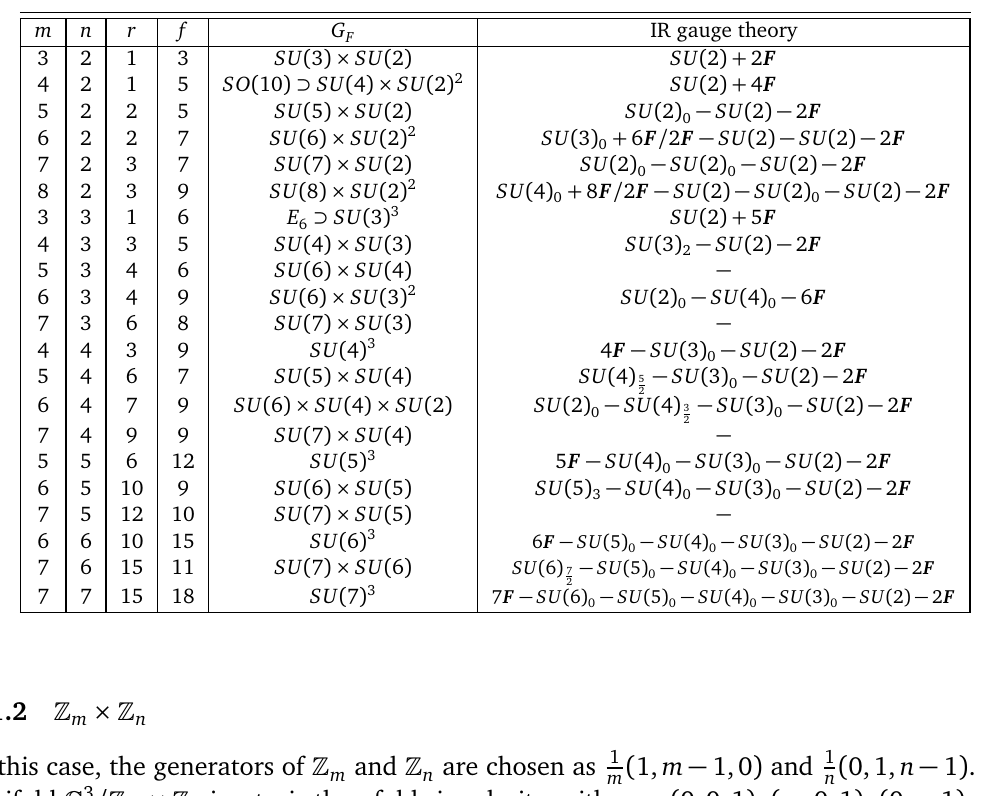
Table 6: List of (cid:67) 3 / (cid:90) theory descriptions of the corresponding 5d